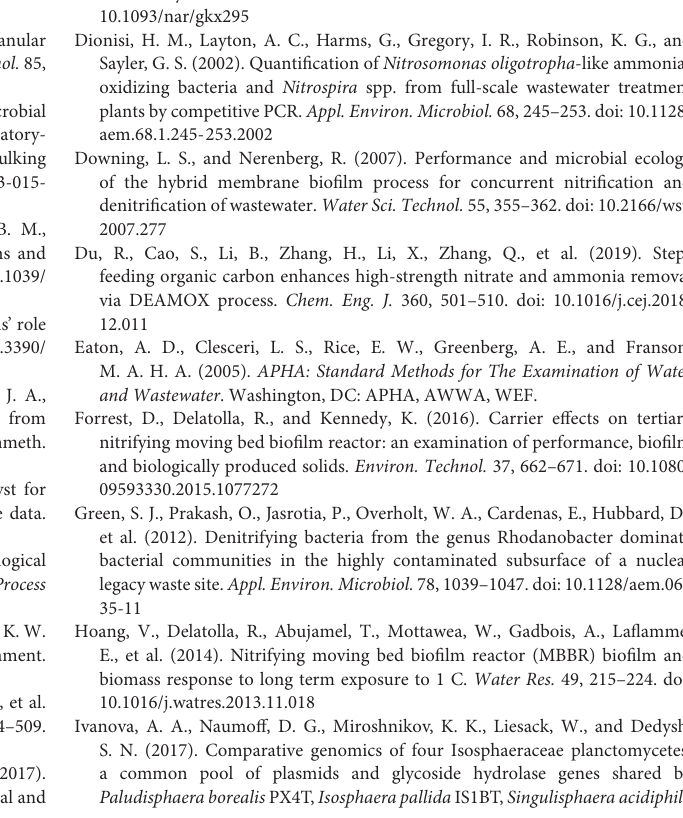
FIGURE S1 | The BioCord TM carrier media, the rings of biocord interwoven on a central cord to support biofilm formation. FIGURE S2 | The attached biomass during the early stage and the relatively mature biofilms on MBBR and BioCord TM carrier media. FIGURE S3 | The sludge volume index (SVI) of the suspended biomass of hybrid bioreactor gradually decreased with increasing influent ammonia concentration. FIGURE S4 | Heat map tree illustrating microbial diversity at (A) the bacterial class level, and (B) family level. FIGURE S5 | The relative abundance of predominant bacterial families (top 20) in the hybrid and fixed-film bioreactors. FIGURE S6 | The relative abundance of predominant bacterial genera (top 10) in the hybrid and fixed-film bioreactors. FIGURE S7 | The relative abundance and dynamics of predominant (A) nitrifying bacteria, and (B) denitrifying bacteria with influent ammonia concentration in the hybrid and fixed-film